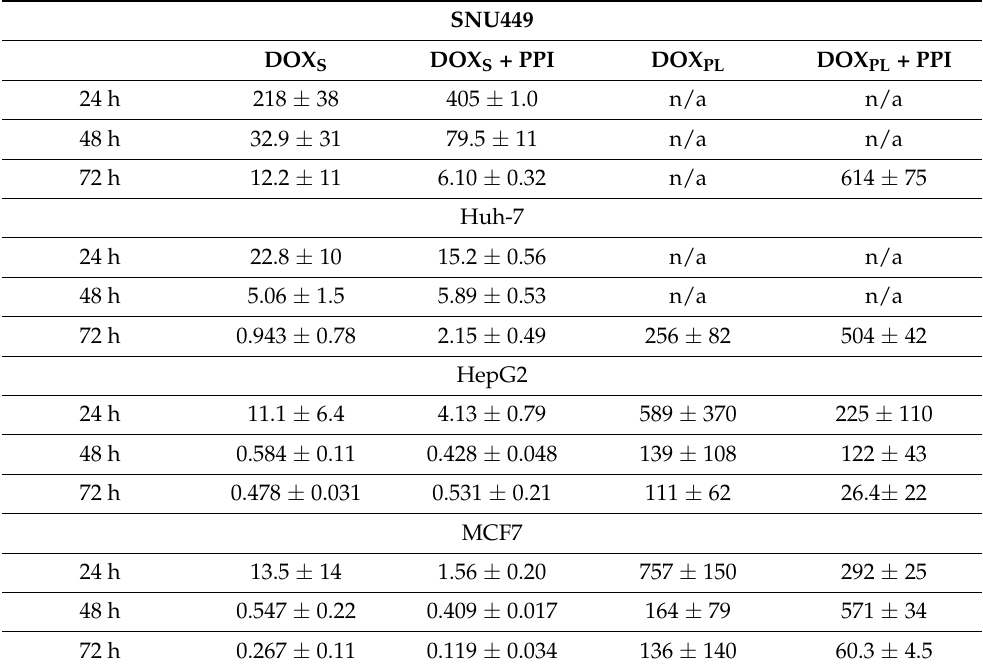
Table 1. The calculated mean ( ± SD) IC50 values ( µ M) of the different cell lines exposed to DOXS or DOXPL for 24, 48 and 72 h with and without proton pump inhibitor (PPI)